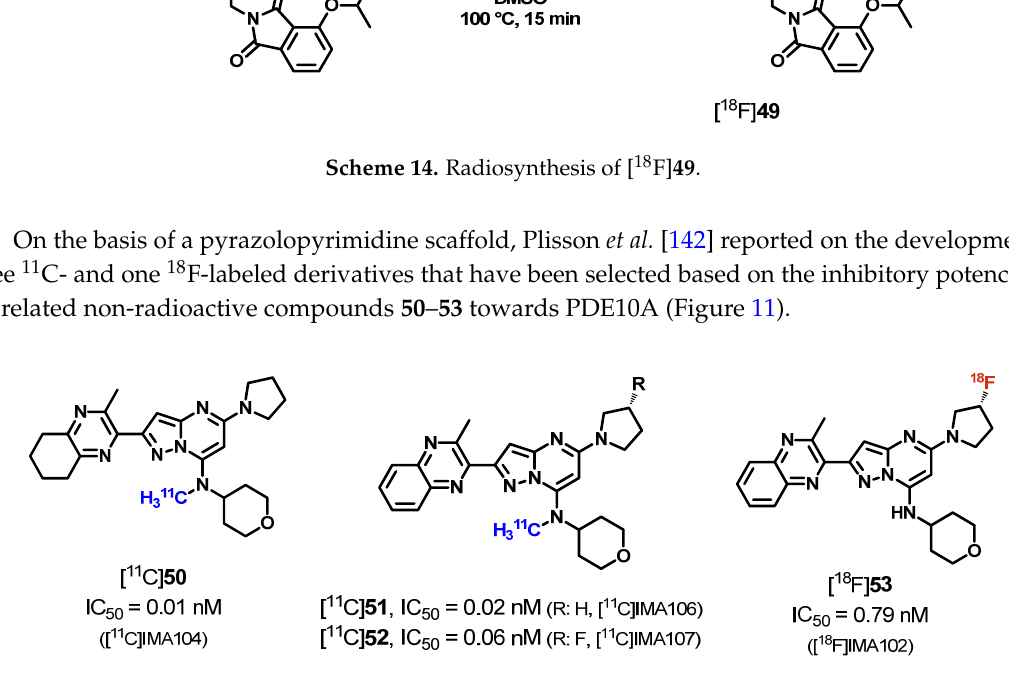
Figure 11. Molecular structures of 11 C- or 18 F-labeled PDE10A radioligands for